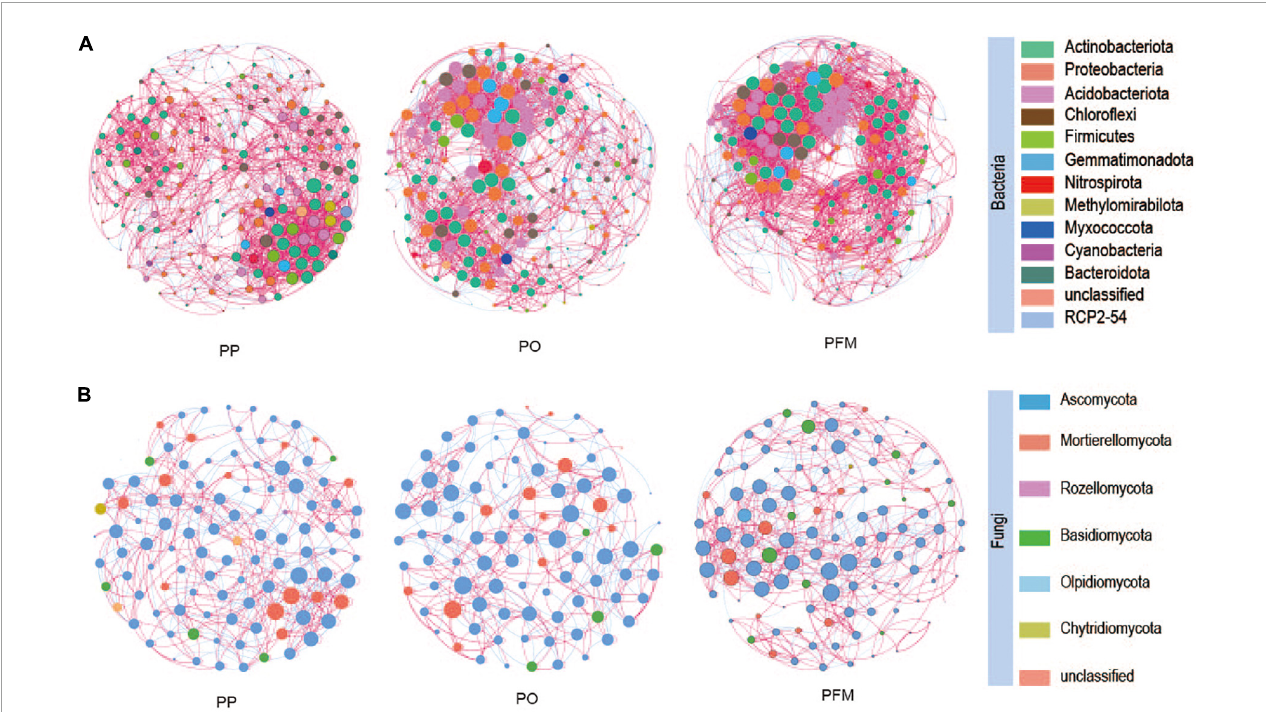
FIGURE4 Co-occurrence network of soil bacteria (A) and fungi (B) in soil based on correlation analysis. A connection stands for a strong (Spearman’s r > 0.6) and significant ( P < 0.05) correlation. The nodes represent a unique genus. The size of each node is proportional to the degree. The nodes are colored by taxonomy. PP, potato continuous cropping; PO, potato–oat rotation; PFM, potato–forage maize